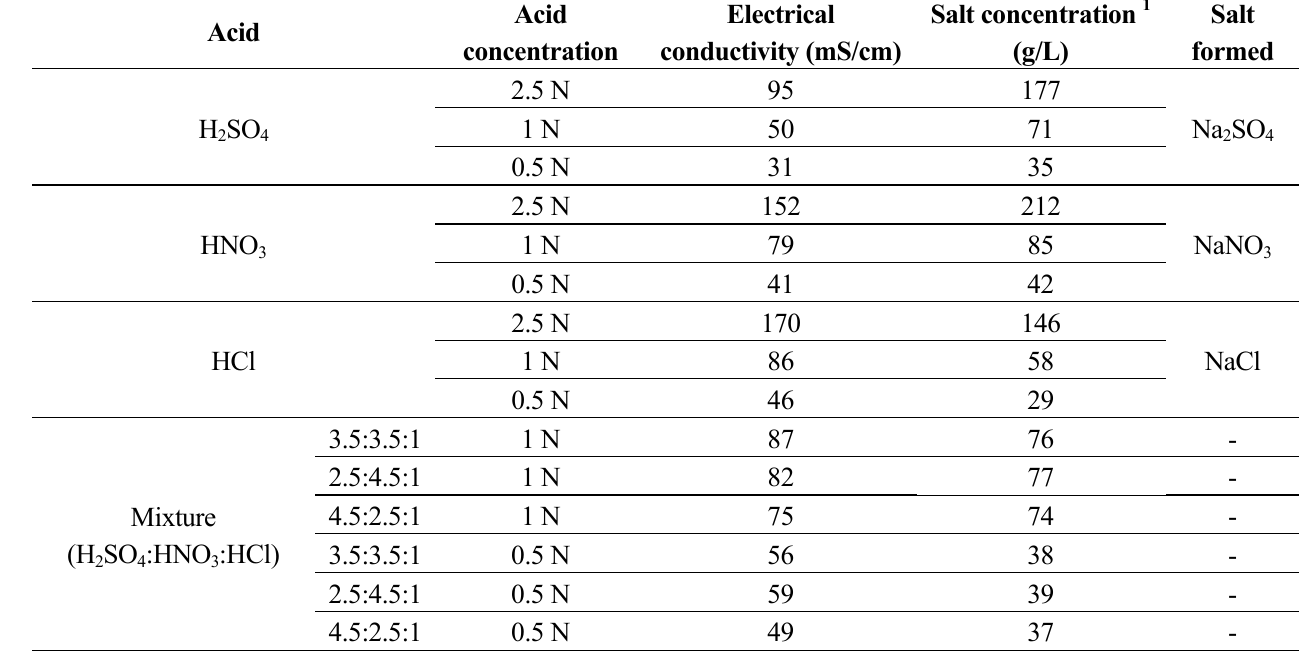
Table 2. Electrical conductivity and salt concentration of the salts formed on hydrolysates after the hydrolysis with several acids and its pH adjustment to 4.5 with